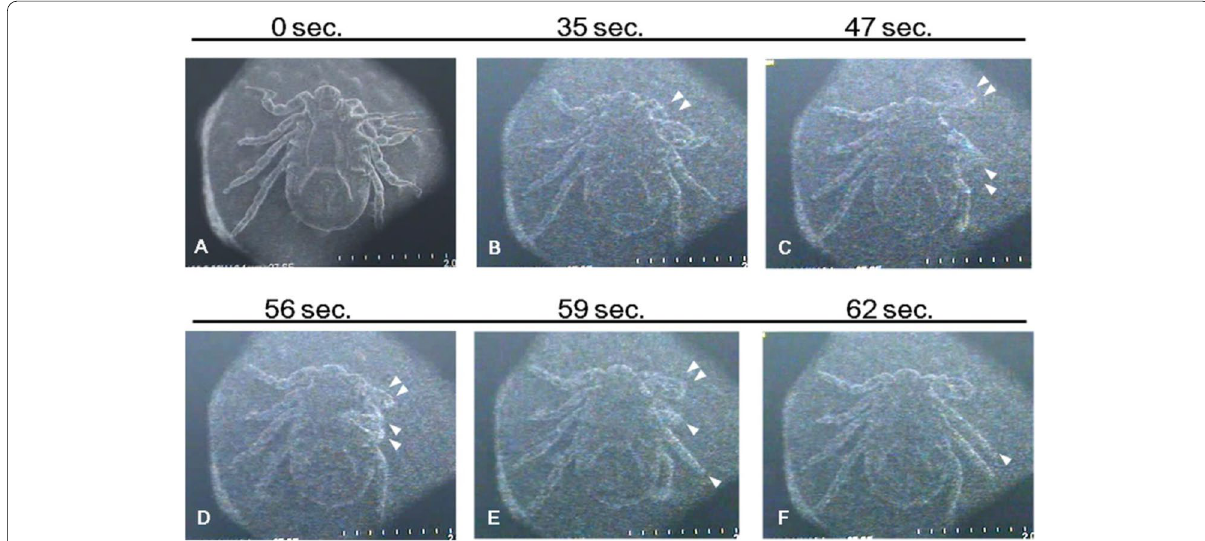
Fig. 5 Scanning electron micrographs of a tick Haemaphysalis flava . A‑F The motion of a live tick. Time under vacuum conditions is shown on the top of each micrograph. Arrowhead leg movement (From Ishigaki et al. 2012 with permission from the publisher) =